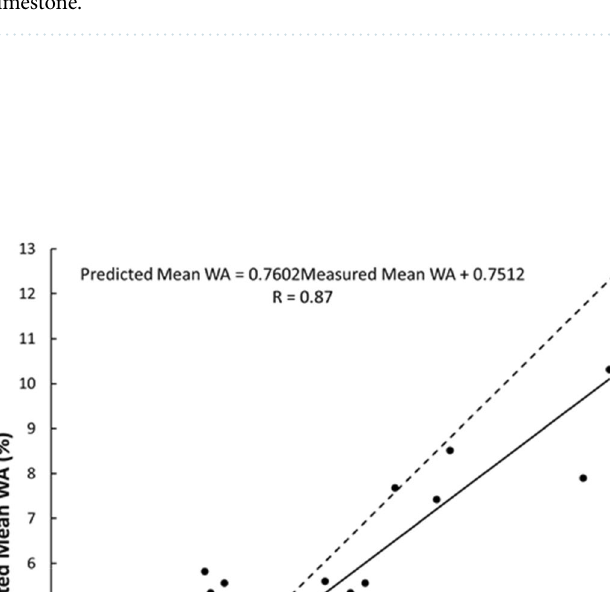
Figure 23. Cross-correlation of the measured and predicted values estimated from V p in terms of G s(C) values of limestone.